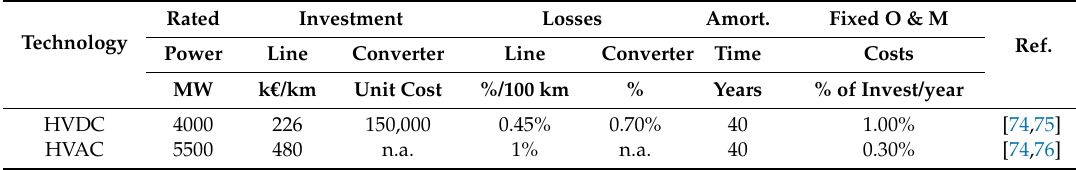
Table A10. Techno-economic parameters of grid